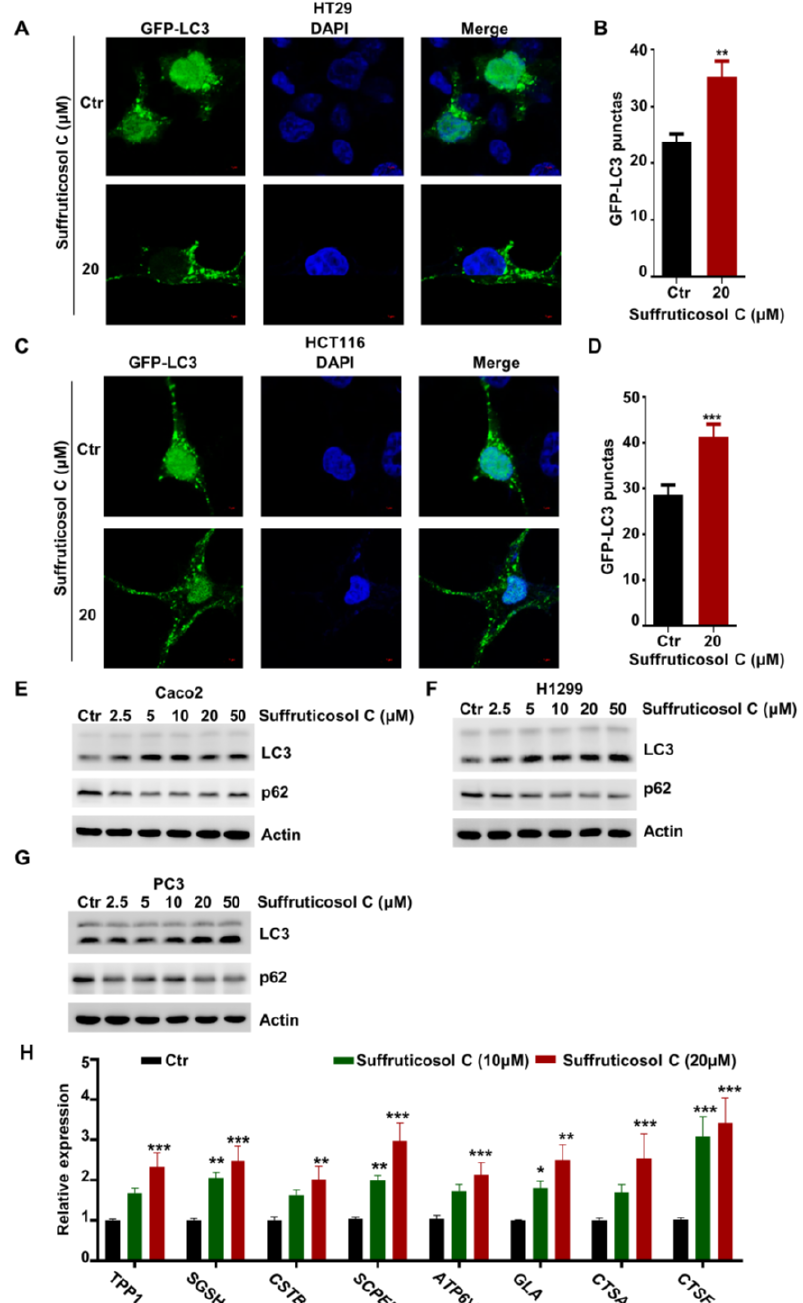
Figure 4. Autophagy-dependent induction of cell death by suffruticosol C. HT29 ( A , B ) and H1299 ( C , D ) cells were treated with suffruticosol C for 24 h, after which cell autophagy was analyzed by examining GFP-LC3 puncta ( A , C ). Quantitative data for the GFP-LC3 puncta are presented ( B , D ). Caco2 ( E ), H1299 ( F ), and PC3 ( G ) cells were treated with different concentrations of suffruticosol C for 24 h, after which autophagy was analyzed by examining LC3II and P62 levels. ( H ). HT29 cells were treated with suffruticosol C for 24 h, and the expression of TPP1 , SGSH , CSTB , SCPEP1 , ATR6V1H , GLA , GTSA , and CTSF was detected by qRT-PCR. Data were analyzed by unpaired two- tailed Student’s t -test ( B , D ) or two-way ANOVA (H), and the results were expressed as Mean ± SEM ( B , D ) or Mean ± SD ( H ). *, p <0.05; **, p <0.01; ***, p